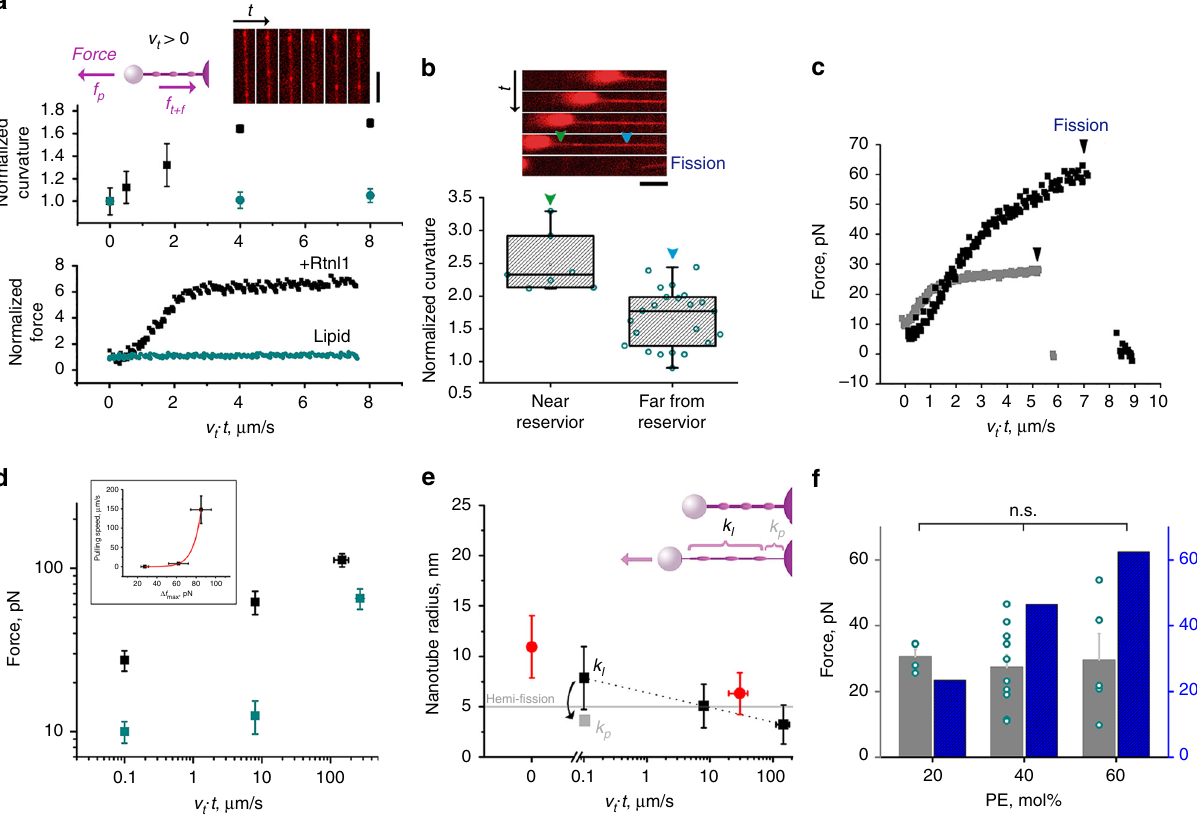
Fig. 5 Constriction-by-friction mechanism of Rtnl1-driven membrane fi ssion. a Simultaneous increase of the pulling force and the curvature (both normalized to their initial static values) during the elongation of control (cyan, n = 3 tubes) and Rtnl1-containing (black, n = 3 tubes) nanotubes at constant speed v t . Error bars represent S.E.M. The image sequence shows the nanotube region used for the curvature calculations (Rh-DOPE fl uorescence, scale bar 5 μ m). The cartoon illustrates the dynamic force balance ( f p = f t + f f ), where the pulling force is equal to the sum of the tensile and friction forces. b Frame sequence (100 ms/frame) showing scission (arrow) of Rtnl1-nanotube. Scale bar 2 μ m. The histogram displays the increased membrane curvature near the membrane reservoir on the pulling pipette (green arrow, n = 7 tubes) as compared to the curvature far from the reservoir (blue arrow, n = 20 tubes). Boxplots show IQR, whiskers indicate minimum and maximum of the dataset. c The increase of the axial force during elongation of Rtnl1-nanotubes at 0.1 μ m/s (gray) and 8 μ m/s (black) speeds caused fi ssion seen as an abrupt decrease of the force to zero (arrows). d Dependence of the axial force measured at the moment of fi ssion of Rtnl1-containing tubes ( f Rtnl1 , black, n = 10 ( v t = 0.1 μ m/s), n = 5 ( v t = 8 μ m/s) n = 12 ( v t = 106 μ m/s)) or maximal force measured during 10 μ m elongation of lipid tubes ( f lip , cyan, n = 9 ( v t = 0.1 μ m/s), n = 34 ( v t = 8 μ m/s) n = 24 ( v t = 106 μ m/s)) on the elongation speed v t . The inset shows the force difference Δ f max = ( f Rtnl 1 − f lip ) dependence on v t , where the red line is the logarithmic fi t (Supplementary Eq. (27)). The error bars show SD, three independent Rtnl1 preparations were used. e Radial constriction of the membrane nanotube measured by fl uorescence microscopy (red, the error bars show SD, n = 25 tubes for both static and dynamic constriction) and recalculated from the force increase (shown in ( d )) using either k l (black) or k p (gray). f Effect of the addition of conical lipids on the pulling force at the moment of fi ssion and fi ssion probability. The PE amounts indicated correspond to 20 mol% DOPE ( n = 17 tubes, fi ssion in 4 out of 17 cases) 40 mol% DOPE ( n = 28 tubes, fi ssion in 13 out of 28 cases) and 40 mol% DOPE + 20 mol% plasma ( n = 8 tubes, fi ssion in 5 out of 8 cases). Statistical signi fi cance: one-way ANOVA with multiple comparison. Source data are provided as a Source Data fi